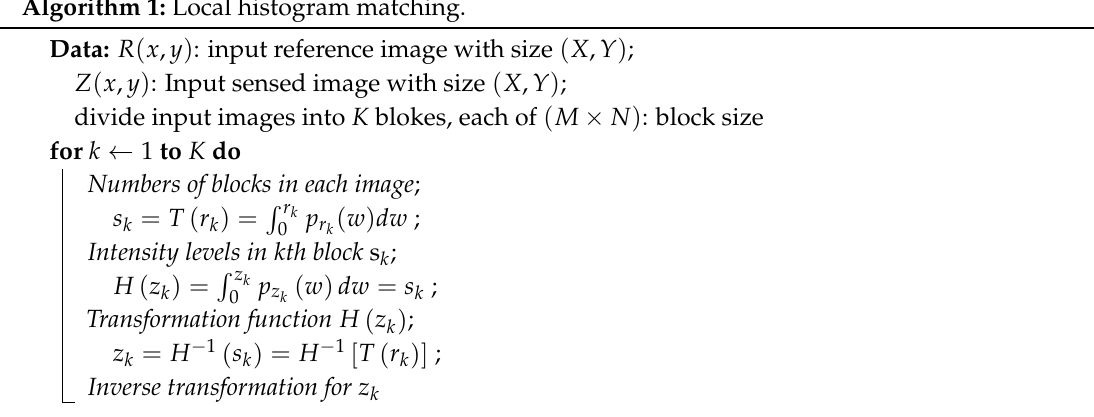
Algorithm 1: Local histogram matching.